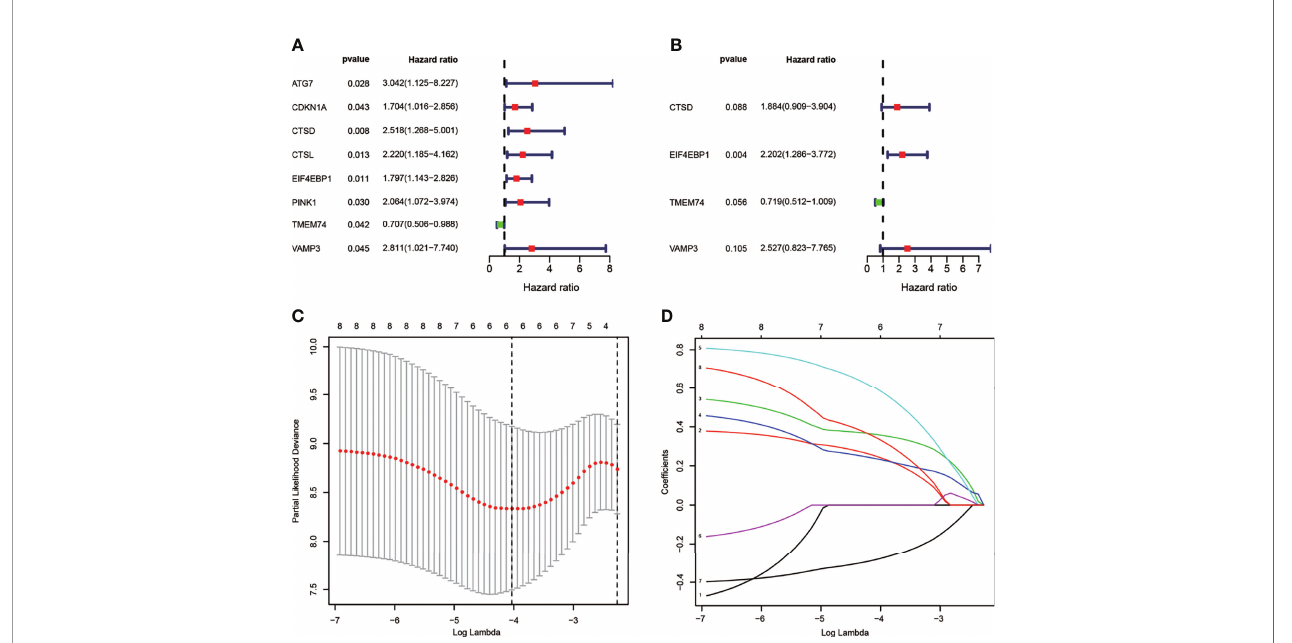
FIGURE 3 | Identi fi cation of ARGs with prognostic value in breast cancer. (A) Univariate Cox regression hazard model for the overall survival in TNBC. (B) Multivariate Cox regression hazard model for the overall survival in TNBC. (C) LASSO regression analysis of ARGs based on univariate Cox regression analysis. The horizontal axis represents the log value of the independent variable l , whilst the vertical axis represents the partial likelihood deviance of the log value of each independent variable l . (D) Coef fi cients were calculated for each lambda. Each line represents a gene con fi dence value.